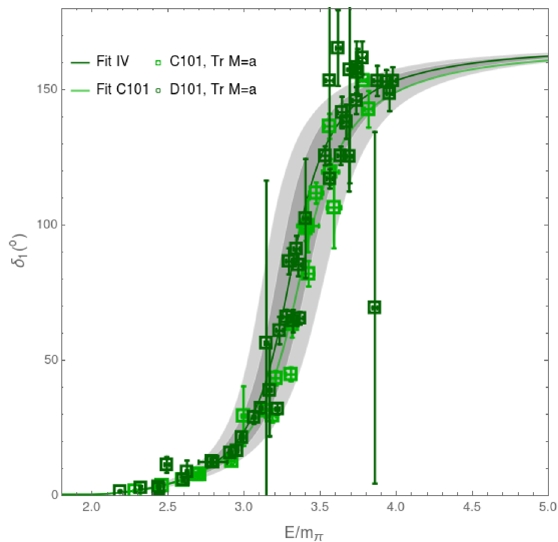
Figure 22 . Comparison between the IAM solutions in Fit IV for D101, with error bands, and the individual (cid:12)t to the C101 data using the averaged lattice spacing.